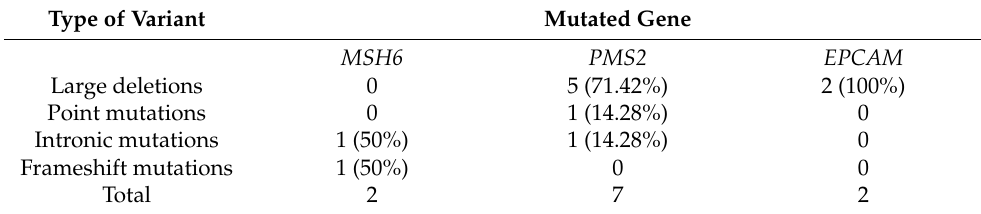
Table 4. Types of variants per MMR gene in unaffected